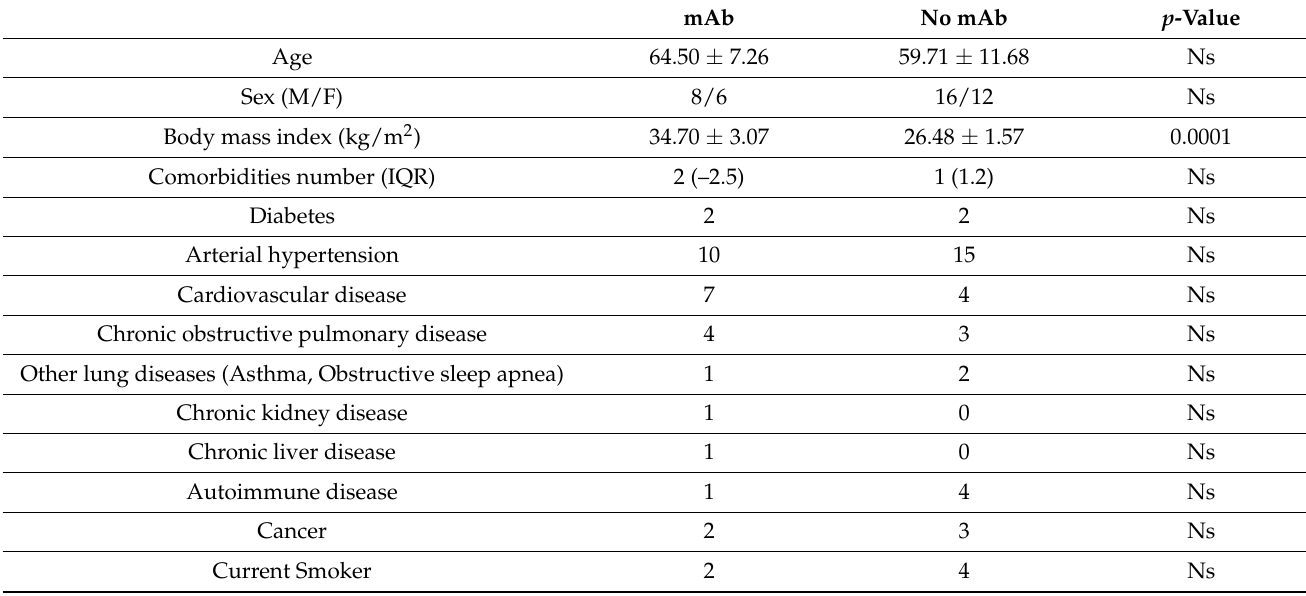
Table 1. Clinical features of Group 1 (mAb) and Group 2 (no mAb) patients. mAb No mAb p -Value 64.50 ±